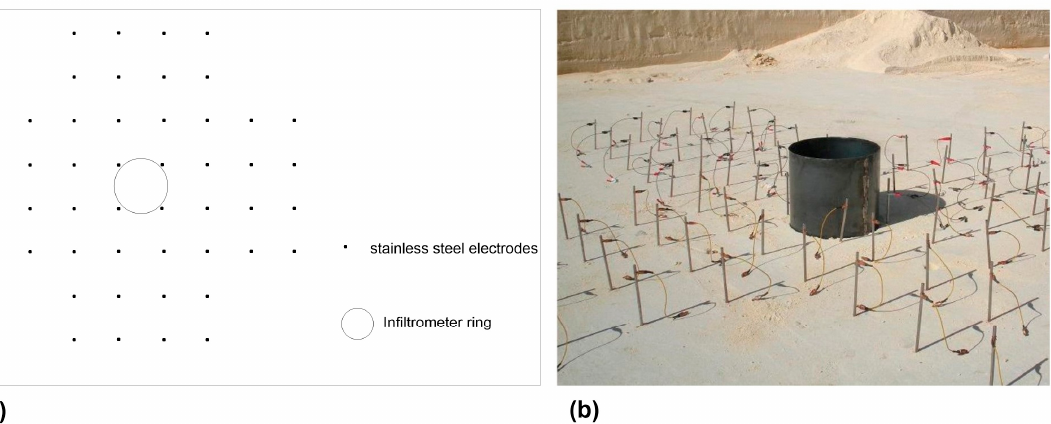
Figure 2. Experimental set up of the infiltrometer test: ( a ) technical drawing of the experimental set up in a plan view; ( b ) picture of 3D electrodes’ configuration arrangement.